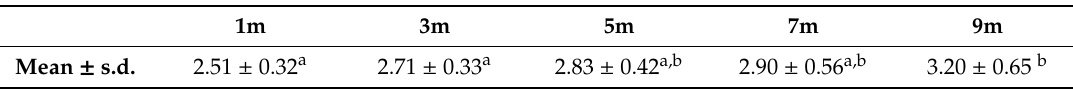
Table A1. Pixel-based root-mean-square error (RMSE) between the original 30 m and the resampled 30 m LST products from the sharpened products (1–9 m).